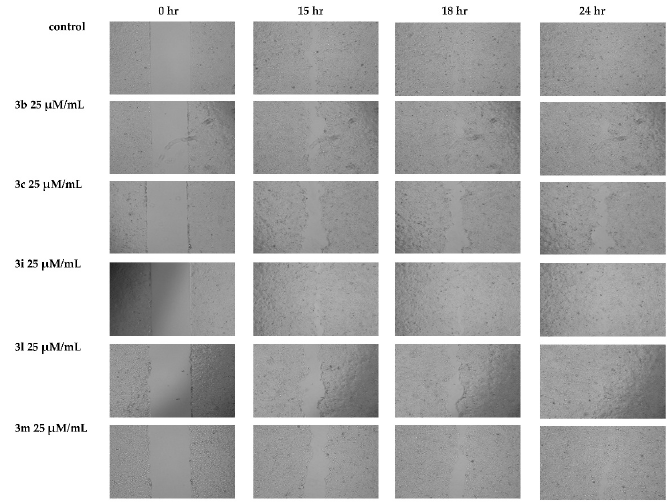
Figure 2. Representative images showing wound closures in HaCaT cells 0, 15, 18, and 24 h after wounding. Compounds 3b , 3c , 3i , 3l , and 3m were added to the medium to test their effects on wound healing (magnification: 4× objective). The groups with the strongest effects on cell migration are displayed in this figure. The remaining groups are shown in the supplementary materials.